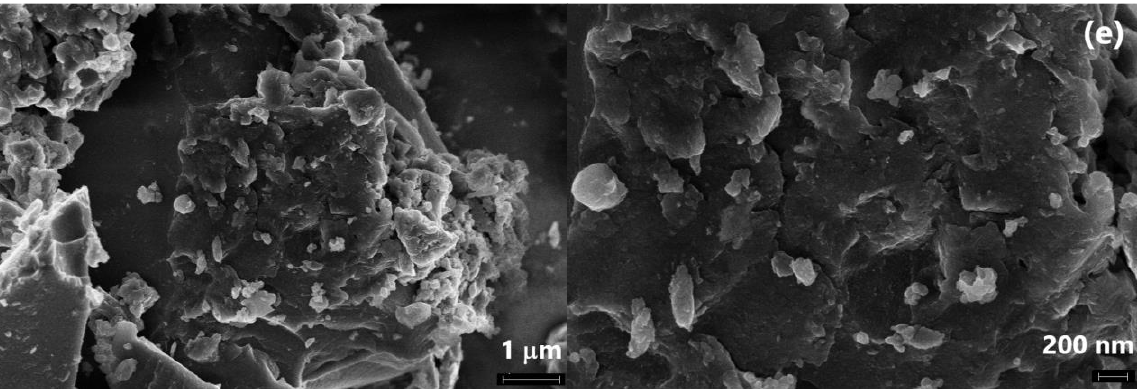
Figure 11. FE-SEM images of IR-PAN-a ( a ), IR-PAN-a/PDPAC ac ( b ), IR-PAN-a/PDPAC alk ( c ), IR-PAN-a/PDPAC ac-IR ( d ), and IR-PAN-a/PDPAC alk-IR ( e ).